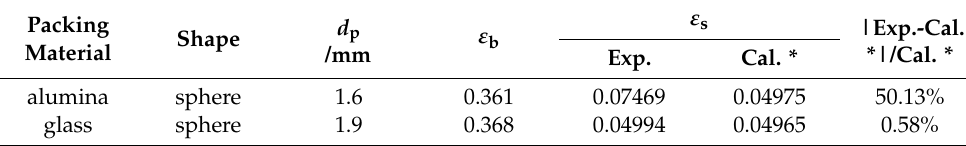
Table 1. Packing characteristics and static liquid